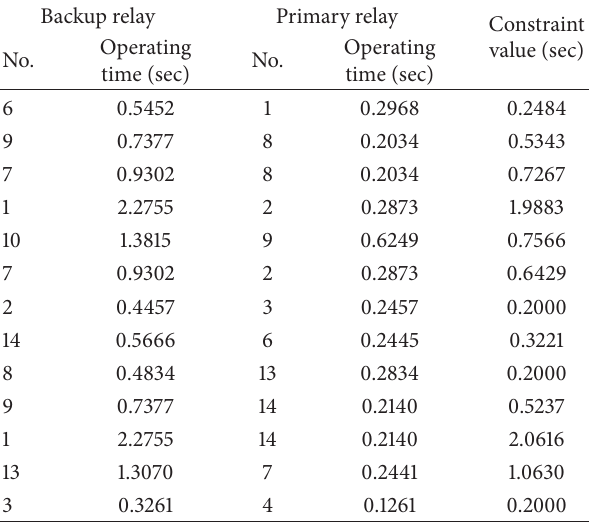
Table 8: Operation times of primary/backup relay pairs after the removal of Line 65 (near-end faults) using the proposed NM-PSO method.